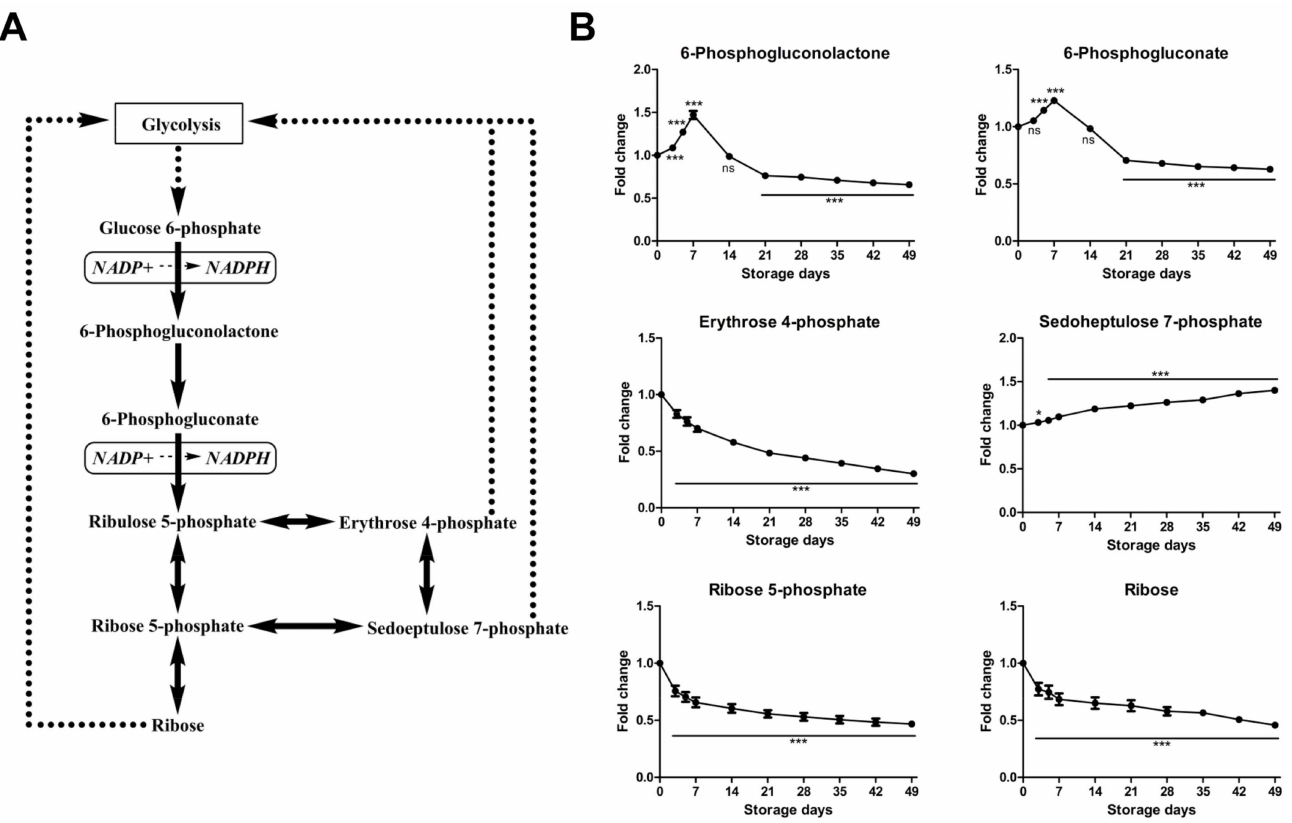
Figure 3. An overview of pentose phosphate pathway ( A ) and time-course changes of metabolites involved in this pathway ( B ) during RBC storage in MAP. Fold change was normalized against day 0 controls. Data are mean ± SD ( n = 8); * p < 0.05, *** p < 0.001, ns (not significant), compared with day 0